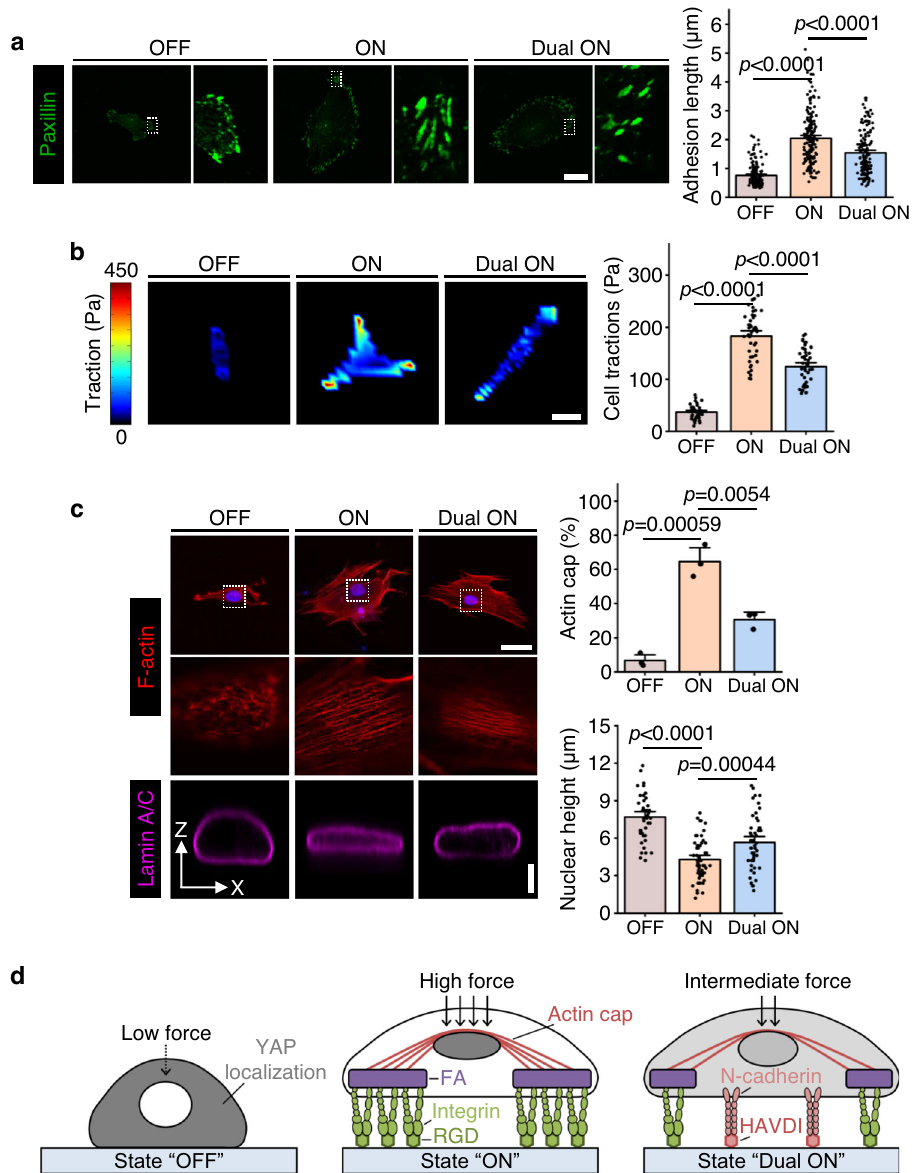
Fig. 4 | RGD/integrin and HAVDI/N-cadherin ligations regulate the adhesive stateandthecytoskeletalorganizationofhMSCs.a Left:Representative paxillin imagesinhMSCson “ OFF ” , “ ON ” and “ DualON ” substratesfor1d.Zoomedregions correspond to the rectangles marked in white in the main images. Right: Corre- sponding quanti fi cation of paxillin adhesion length (from left to right n = 146, 173, 154 adhesions in 41, 47, 45 cells respectively). b Left: Representative heat maps of traction stress in hMSCs on “ OFF ” , “ ON ” and “ Dual ON ” substrates for 1 d. Right: Corresponding quanti fi cation of average traction stress per cell (from left to right n = 37, 44, 47cells). c Left: Representative F-actin images in hMSCs on “ OFF ” , “ ON ” and “ Dual ON ” substrates for 1 d (top). Zoomed regions display details of F-actin organization in the apical region of the nucleus (middle). The cross-sectional side view of lamin A/C staining was captured along the XZ-plane crossing the center of the nucleus (bottom). Right: Corresponding quanti fi cation of the percentages of